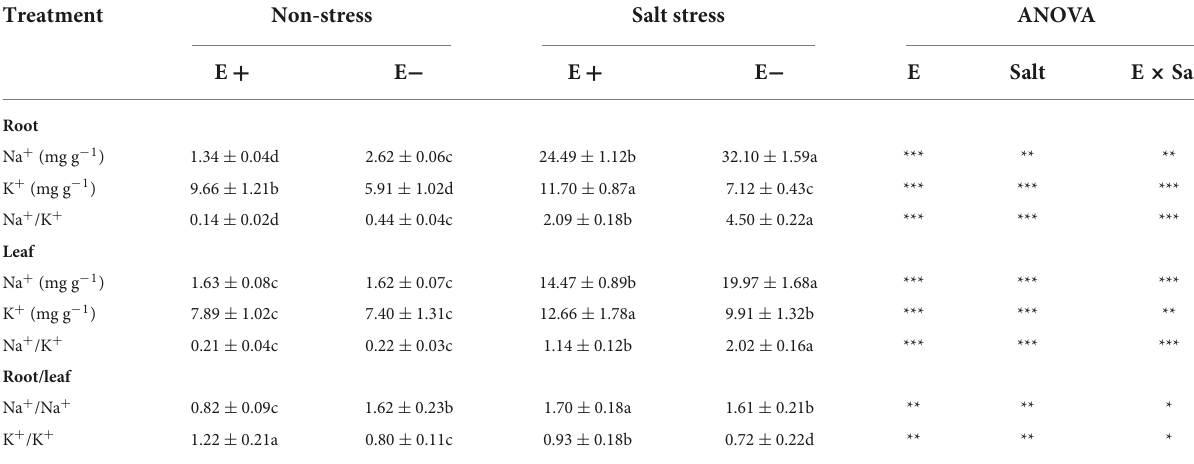
TABLE 2 Influence of Enterobacter ludwigii B30 on Na + , K + , Na + : K + ratio in roots and leaves, Na + (root) to Na + (leaf) ratio and K + (root) to K + (leaf) ratio of bermudagrass in the presence and absence of salt stress. Treatment